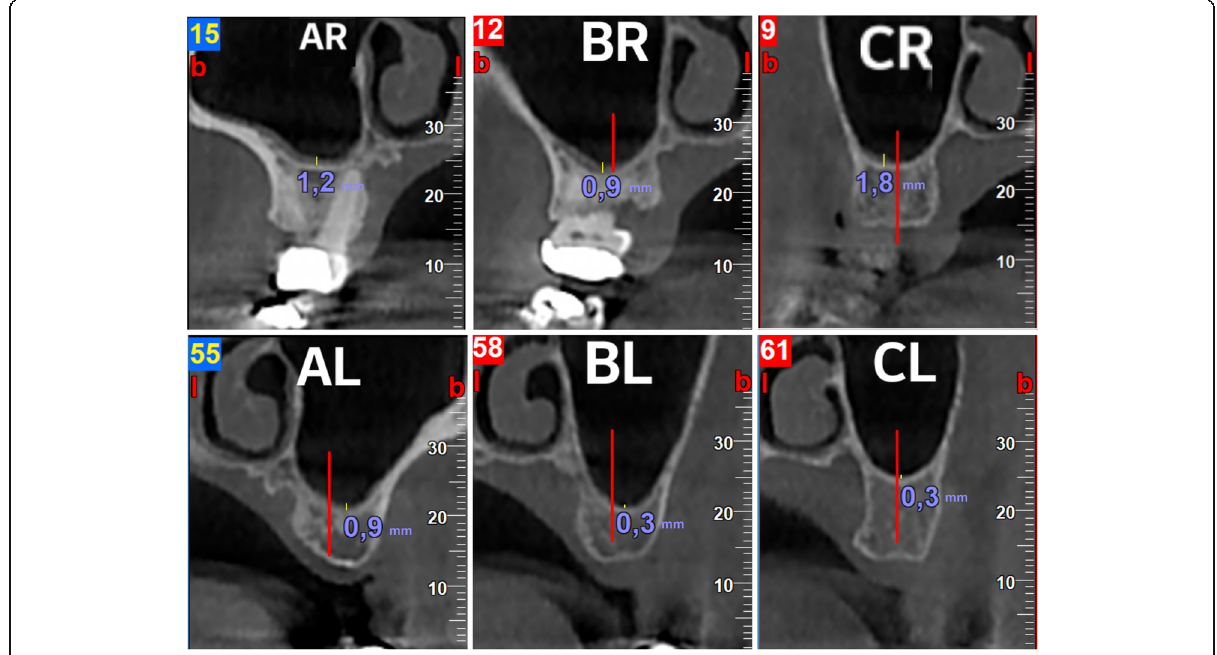
Fig. 2 Demonstration of the method used to measure the thickness of the Schneiderian membrane in the cross-sectional images for each of